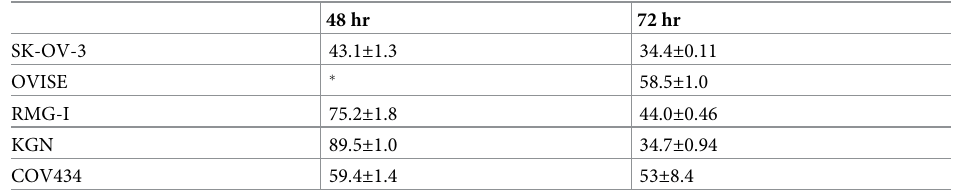
Table 1. IC50 (nM) of PS in GCT and ovarian cancer cell